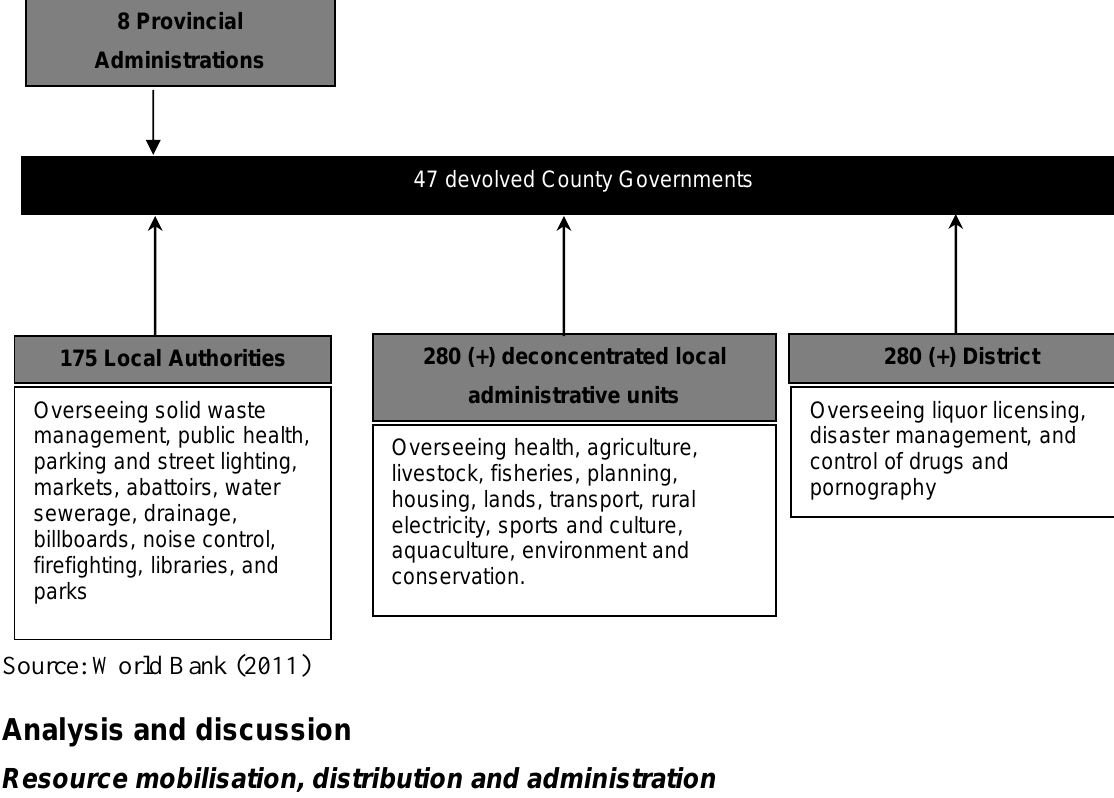
Figure 1: How the county governments were